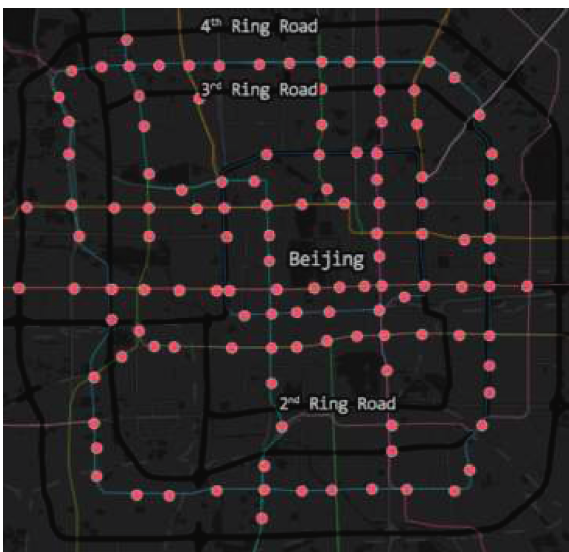
Figure 2: Centroids in the traffic zone.